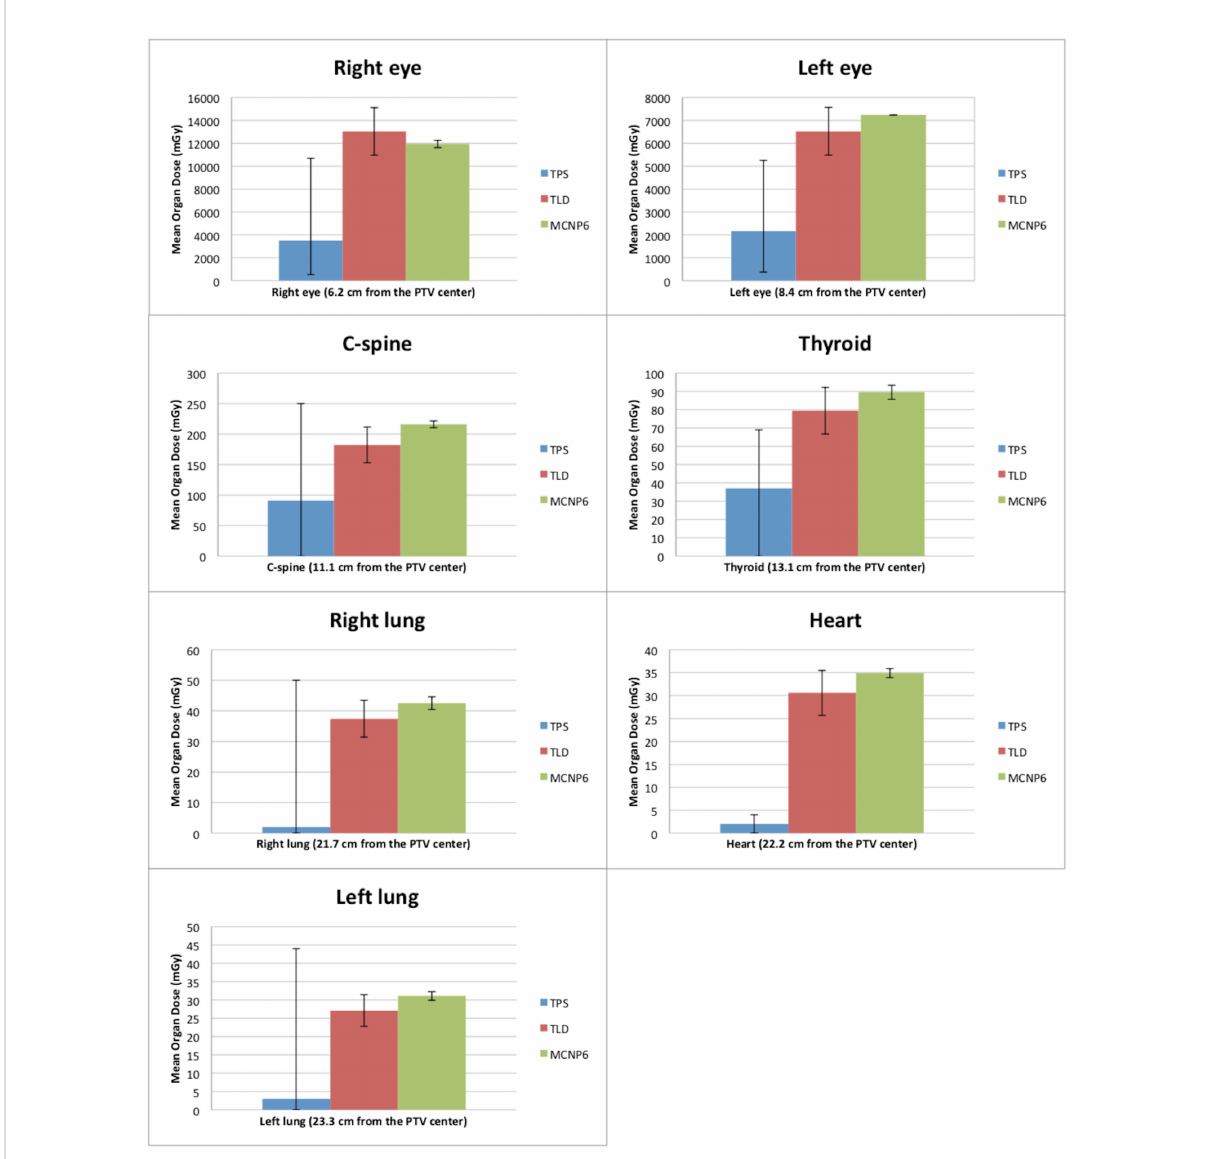
FIGURE 3 Comparison between doses outside the treatment fi elds obtained by TPS, TLDs, and MC for the IMRT technique. The error bars of the TPS dose calculations de fi ne the interval between the minimum and maximum calculated dose. The error bars of the measurements with the TLDs correspond to measurements of standard deviations. The error bars of the MC simulations correspond to the calculated uncertainty for each